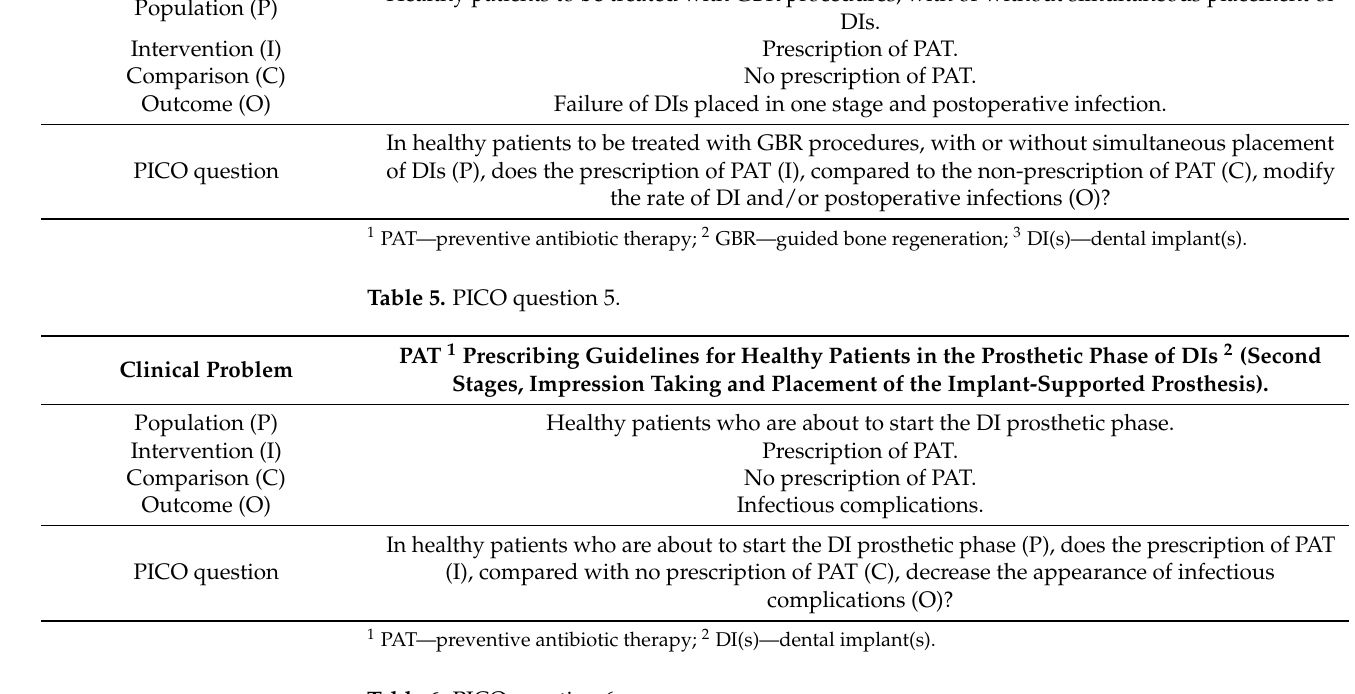
Table 6. PICO question